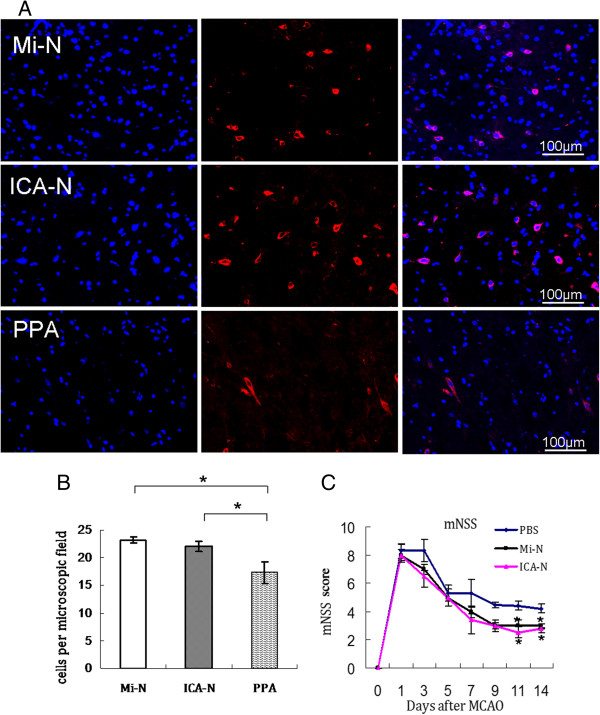
MSCs in the brain. Seven days after injection of DiI-hMSCs using three methods in rats with MCAO, tissue sections of the brain were examined under a florescence microscope for the presence of DiI-hMSCs (red). (A) Representative images are shown. Mi-N, DiI-hMSCs delivered with a micro-injection needle plus PPA ligation; ICA-N, DiI-hMSCs delivered with an ICA injection needle; C, PPA, DiI-hMSCs delivered with a micro-injection needle without PPA ligation. Nuclei were stained with Hoechst (blue). (B) Quantitation of DiI-hMSCs in tissue sections as described in the ‘Methods’ (n = 4, *P <0.05). (C) mNSS scores of rats before and after receiving different treatments at times as indicated. hMSCs were injected one day post MCAO before mNSS evaluation. PBS, injection of equal volume of PBS with a micro-injection needle plus PPA ligation. *P <0.05. DiI, 1, 1′-dioctadecyl-3, 3, 3′, 3′-tetramethylindocarbocyanine perchlorate; DiI-hMSCs, DiI-labeled human mesenchymal stem cells; ICA, internal carotid artery; MCAO, middle cerebral artery occlusion; mNSS, modified neurology severity score; PPA, pterygopalatine artery.